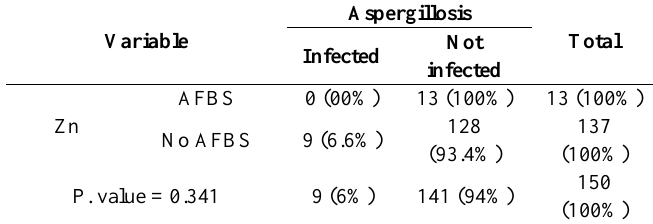
Table 3: Frequency of aspergillosis among Zn positive and